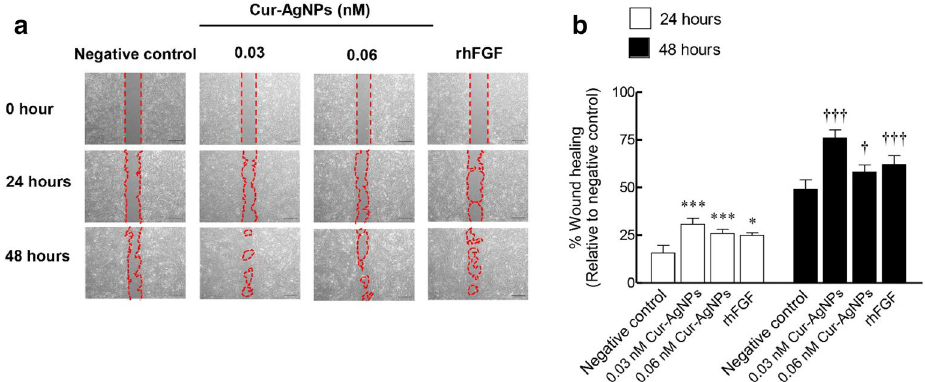
Figure 4. Effects of Cur-AgNPs on wound healing induction. ( a ) Human dermal fibroblast cells were treated with 0.03 and 0.06 nM of Cur-AgNP, or 100 ng/mL of rhFGF-b as a positive control, and a scratch wound assay performed at 0, 24 and 48 h after scratch wounding (compared to no treatment as a negative control). ( b ) Analyzed percentage wound gap width after 48 h relative to the original scratch width. Data were expressed as